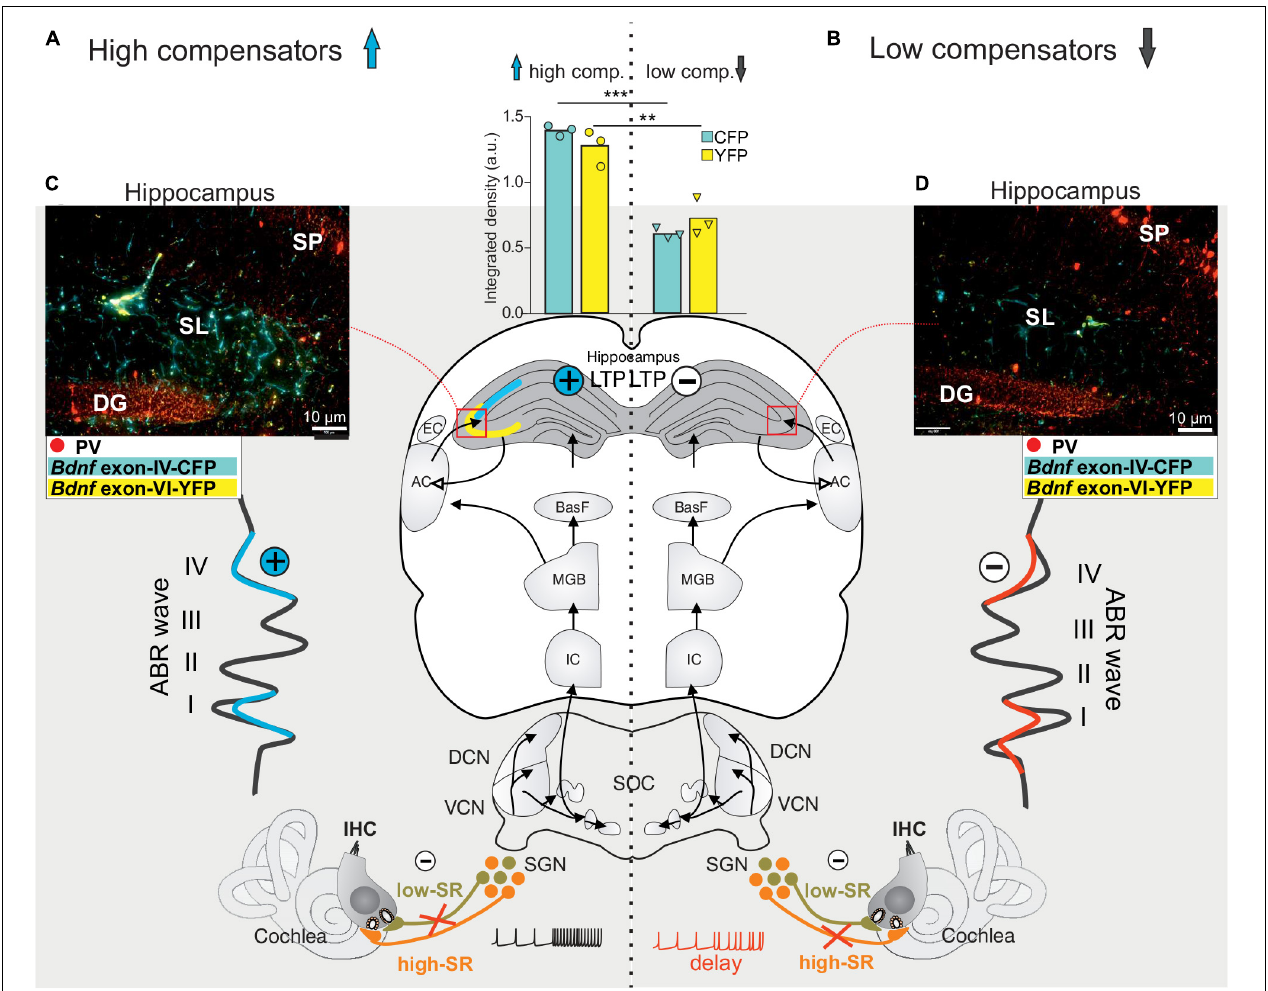
FIGURE 7 | Schematic presentation of high and low central compensatory mechanisms in the aging auditory system. (A) Independent of aging or differences in hearing thresholds, cochlear synaptopathy can differ, depending on whether de-afferentation due to low-SR auditory nerve fiber loss dominates ( A , low-SR in light green) or high-SR auditory nerve fiber loss dominates ( B , high-SR in orange). In the first case, an ABR wave I reduction is associated with disproportionally increased ABR wave IV amplitude ( A , left blue amplitude, plus in blue circle), with elevated Bdnf exon IV (cyan) and exon VI (yellow) expression in hippocampal circuits ( C , left panel and bar graph) and higher hippocampal LTP (plus in blue circle). In the case of a critical loss of fast (high-SR) auditory nerve fiber processing ( B , high-SR in orange), an attenuated temporal resolution capacity of auditory nerve fibers ( B , delay) is associated with permanently decreased ABR wave IV amplitude ( B , red amplitude, minus in white circle), decreased recruitment of hippocampal Bdnf exon IV and exon VI transcripts ( D , right panel and bar graph) and significantly lower LTP mobilization (minus in white circle). ABR, auditory brainstem response; IHC, inner hair cell; VCN, ventral cochlear nucleus; DCN, dorsal cochlear nucleus; SOC, superior olivary complex; IC, inferior colliculus; MGB, medial geniculate body; BasF, basal Forebrain; AC, auditory cortex; EC, entorhinal cortex; PV,